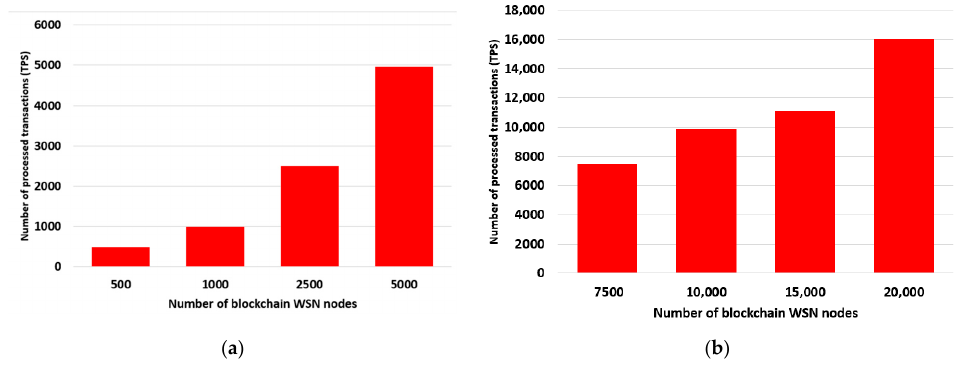
Figure 5. Throughput: ( a ) 500, 1000, 2500, 5000 blockchain WSN nodes; ( b ) 7500, 10,000, 15,000, 20,000 blockchain WSN nodes.